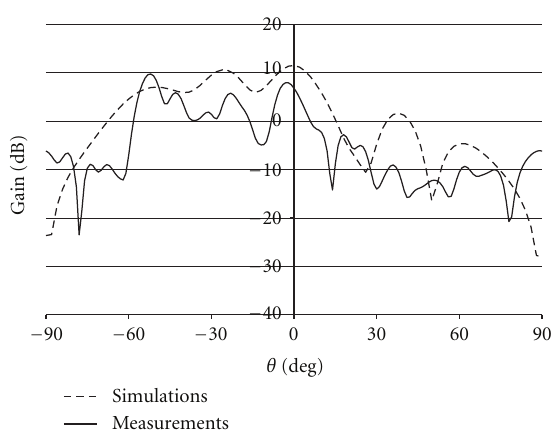
Figure 8: Comparison between measurements and simulations results for the antenna Gain at θ , ϕ = 0 ◦ for the frequency range 12.3–12.8